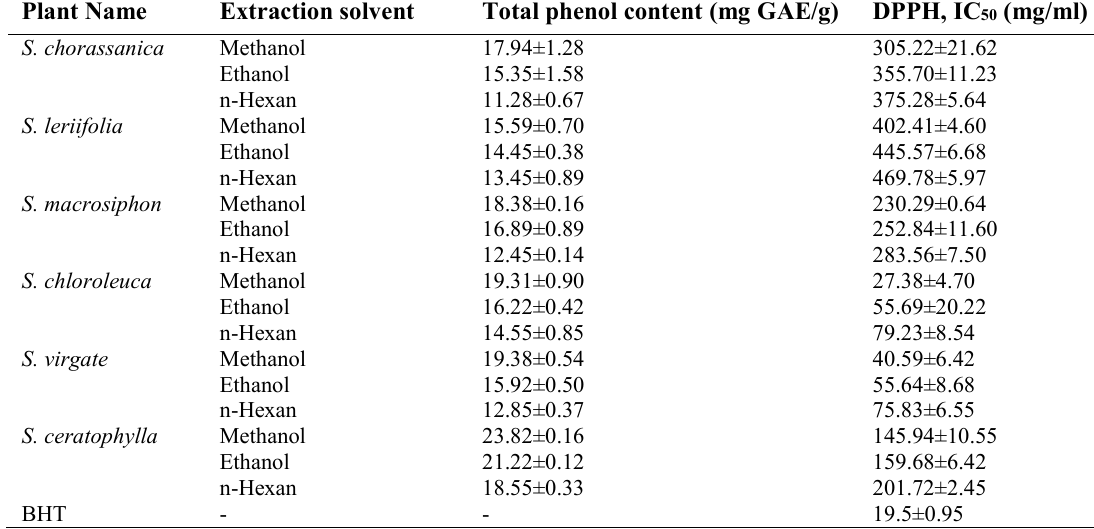
Table 2 . Total phenolic content and DPPH radical scavenging potential of different extract of Salvia species. Values are given as means ± SD of three separate readings. Total phenolic contents expressed as gallic acid equivalent.